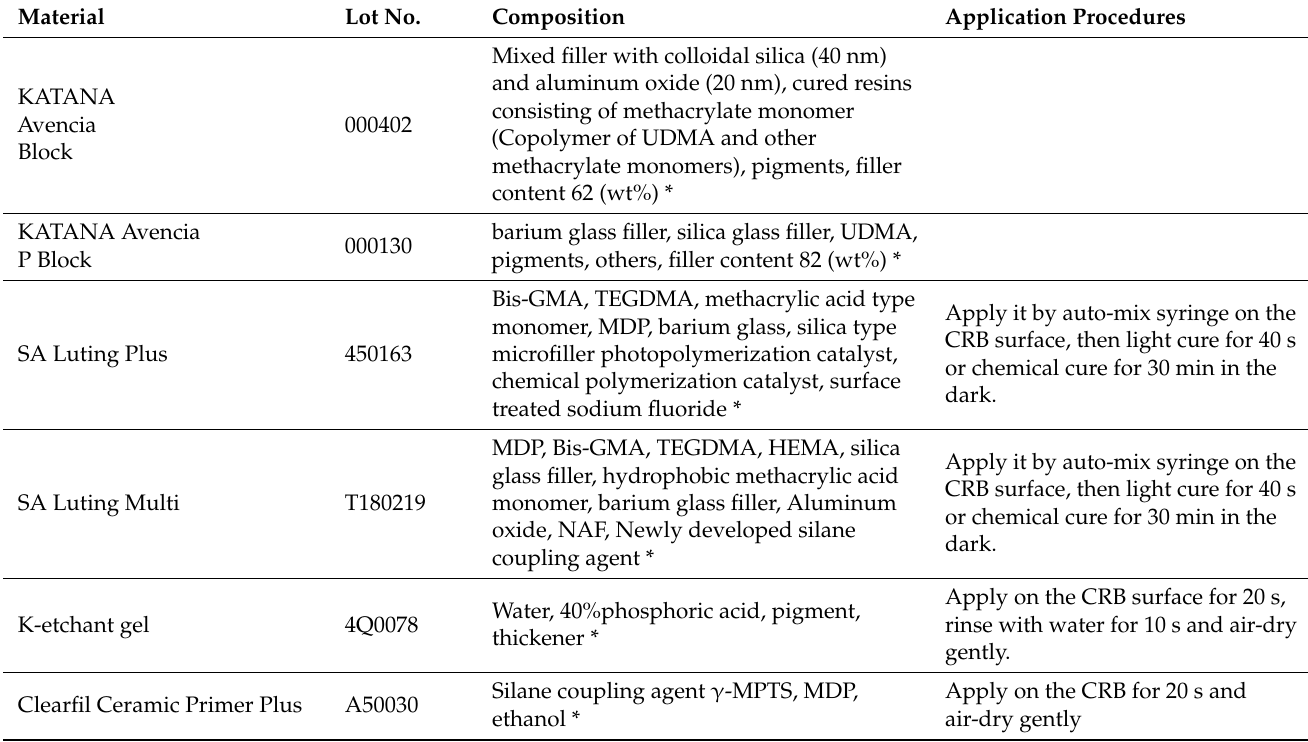
Figure 1. The flowchart of the all study. Table 1. Composition of the materials used in the study and their applications procedures.